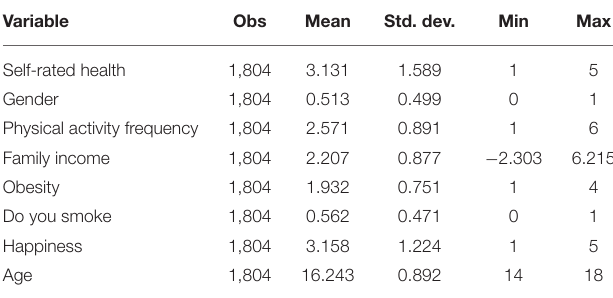
TABLE 1 | Descriptive statistics.